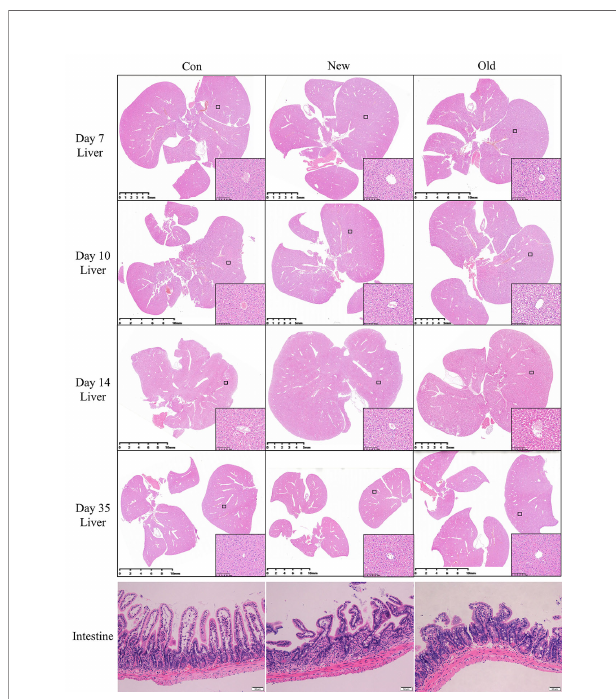
FIGURE 3 | HE liver staining results of mice in the three groups at different time points after damp-heat induction and pathological observation of the intestine at the